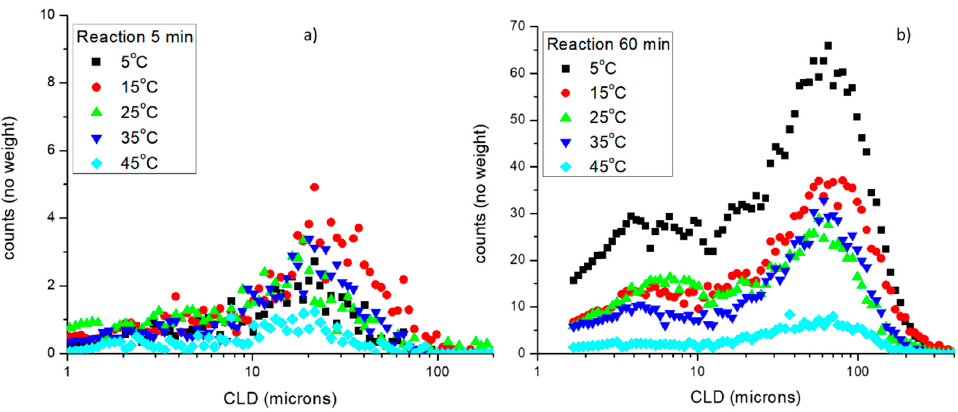
Figure 4. CLDs obtained ( a ) at 5 min and ( b ) at 60 min, i.e., the final product, for different reaction isotherms. In this work, the maximum K 2 SO 4 crystal size obtained according to the semiquanti- tative analysis of CLD was between 70 and 80 μ m at 5 °C, which is small compared with crystallization from pure K 2 SO 4 -H 2 O solutions. For example, Bari and Pandit [24] reported an average size of 286 μ m via the isothermal method for low supersaturation and Bari et